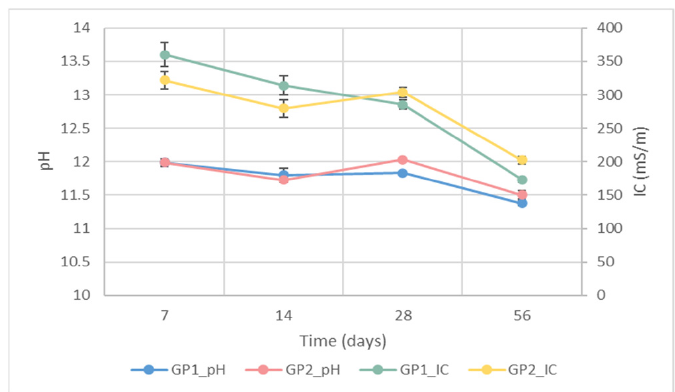
Figure 7. IC and pH values of the eluates obtained after samples GP1 and GP2 were immersed for